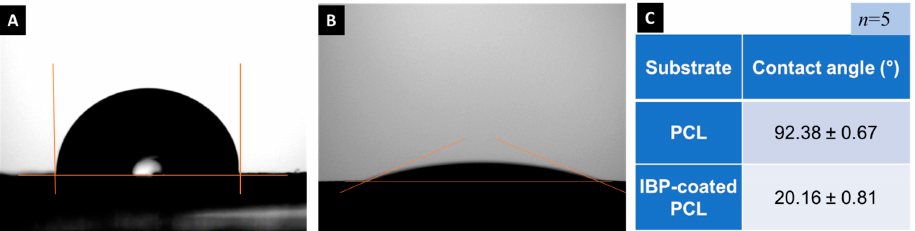
Figure 2. Contact angle analysis was performed to determine wettability of different membranes, including ( A ) PCL and ( B ) IBP ‐ coated membranes. ( C ) Result indicated that hydrophilicity of PCL membranes was improved with IBP coating.